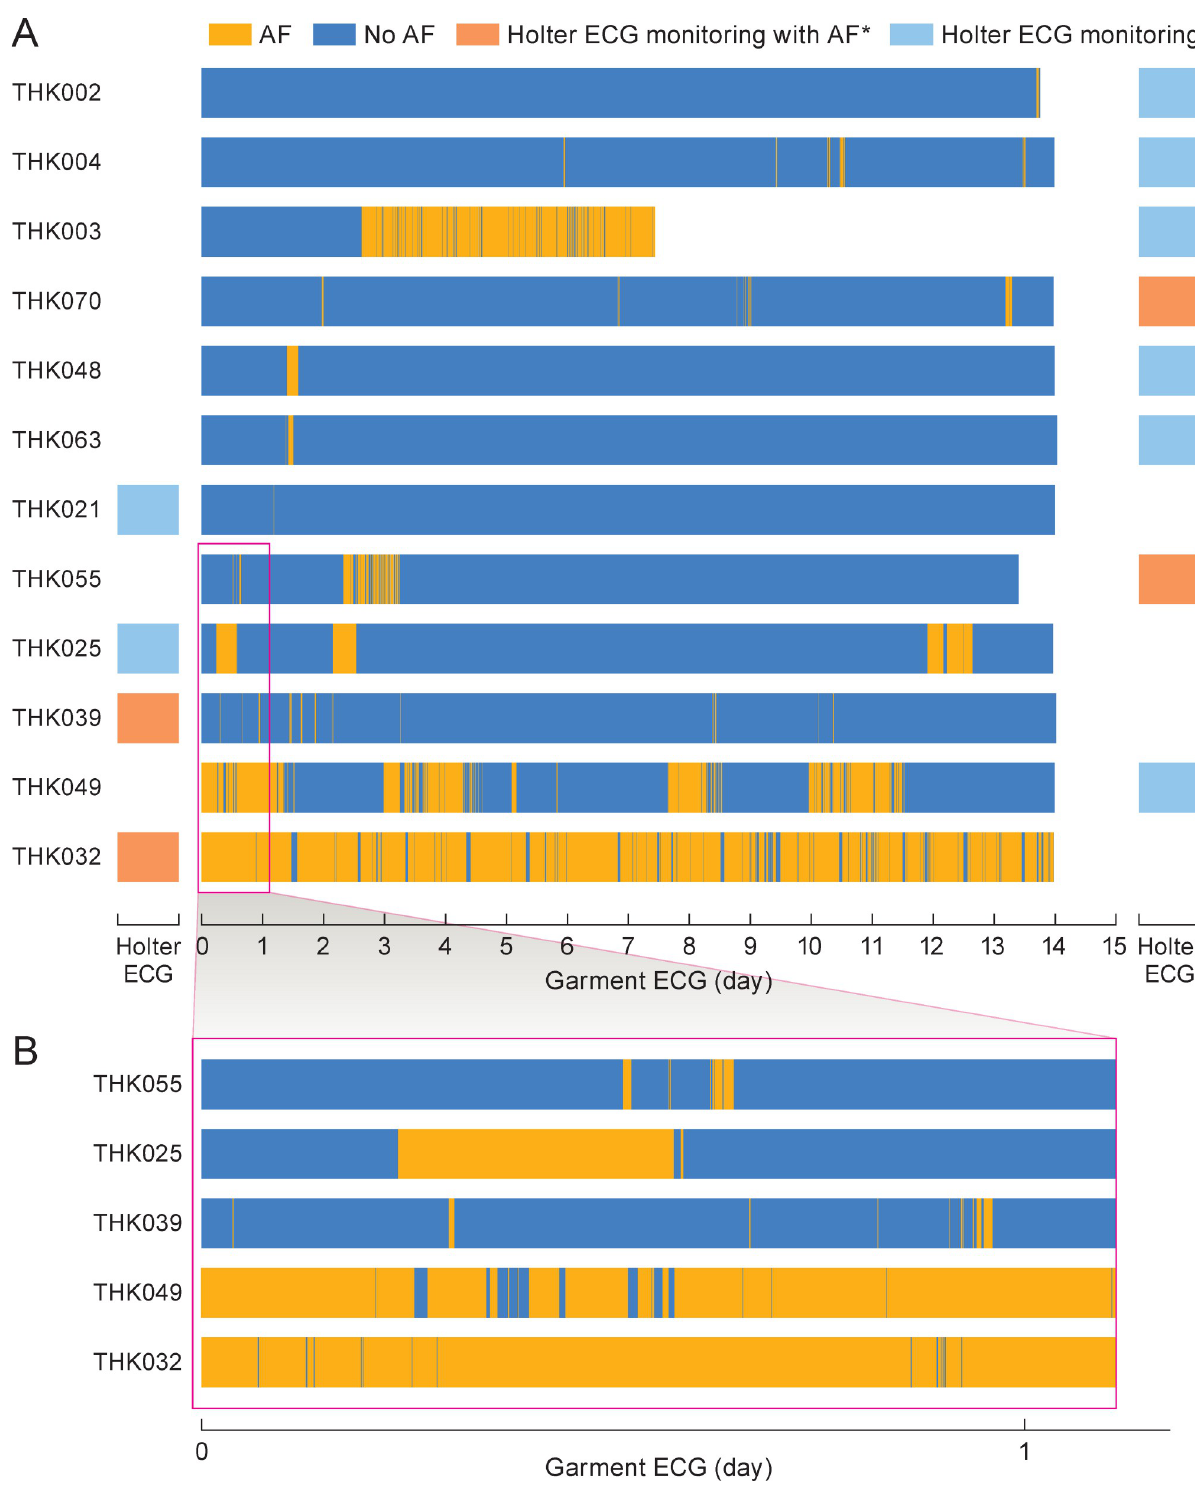
Fig 3. AF occurrences during the follow-up period. A, AF occurrences in 12 relapsed patients. B, Data from 5 patients who had AF on the first day of Garment ECG measurements. � Of the 12 patients, 4 also showed AF on the Holter 24-hour ECG. AF, atrial fibrillation; ECG, electrocardiogram.